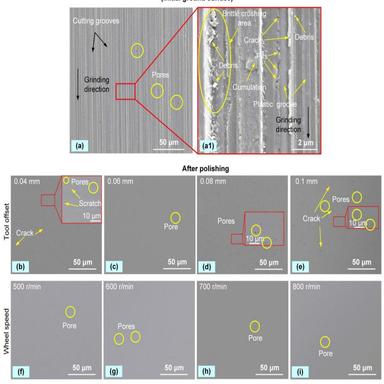
SEM morphology images of the Y-TZP bioceramic samples before and after polishing under different tool offsets and wheel speeds.